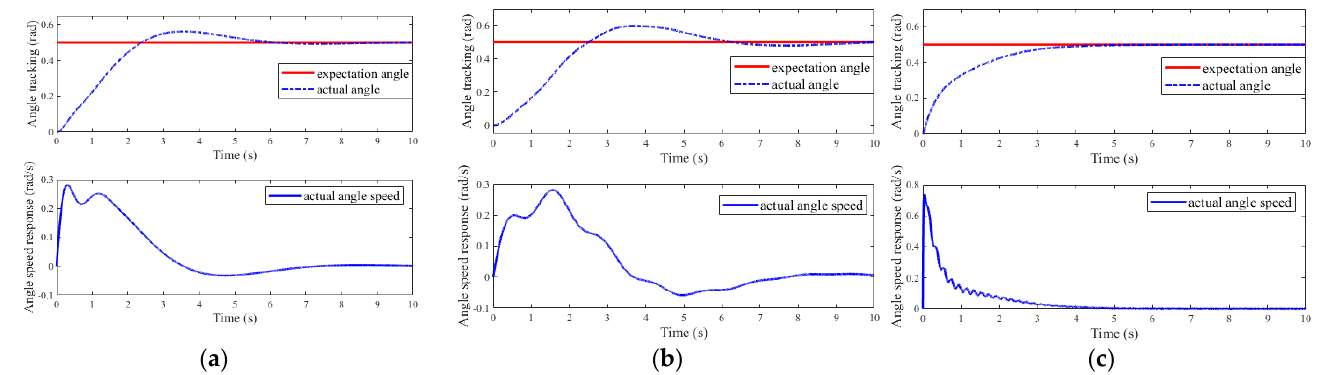
Figure 3. The angle tracking and response results of different methods: ( a ) adaptive boundary method; ( b ) RBF neural network method; ( c ) the proposed method.